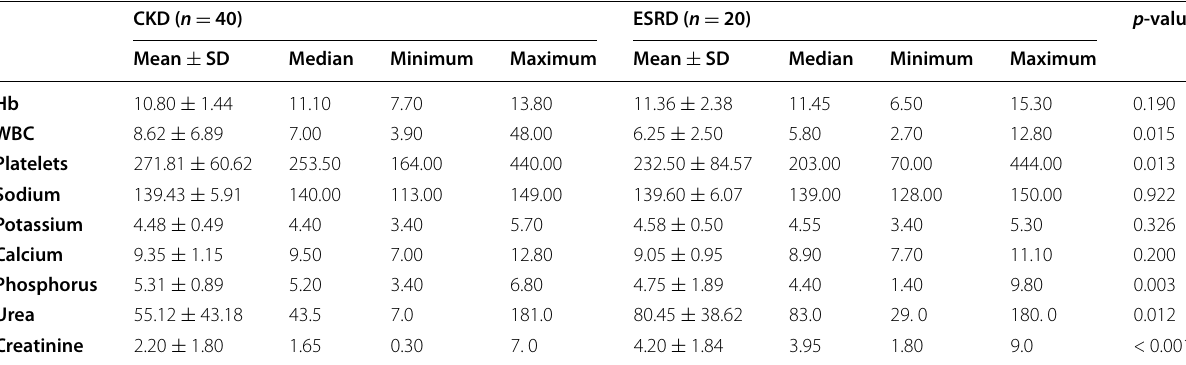
Table 2 Comparison between CKD and ESRD groups regarding laboratory investigations